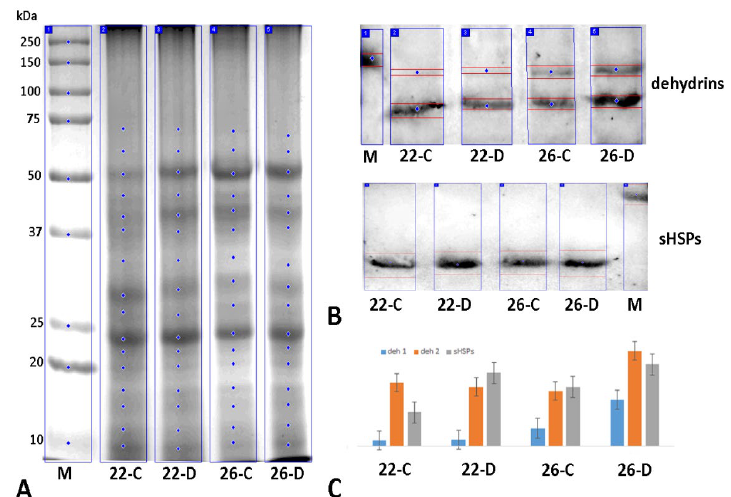
Figure 5. Western blot analysis of expression of dehydrins and small HSPs in common bean mutant lines number 22 and 26 in control (C) and stressed states (D). ( A ) CBB staining of protein extracts from mutant common bean lines in control and stressed states separated by SDS PAGE. Molecular weights of marker (M) are given on left. Each detected band is assigned with blue rhomb. ( B ) Western blot of dehydrins (upper panel) and small HSPs (lower panel). The area of detected immunosignals and marker (M) is defined with red lines and bands are assigned with blue rhomb. ( C ) The mean area of each dehydrin and sHSPs band was normalized to the mean area of the total protein stain. Error bars were calculated from triplicate samples. deh1- upper high molecular band in blue; deh2-lower band in orange; sHSPs small HSP in grey.